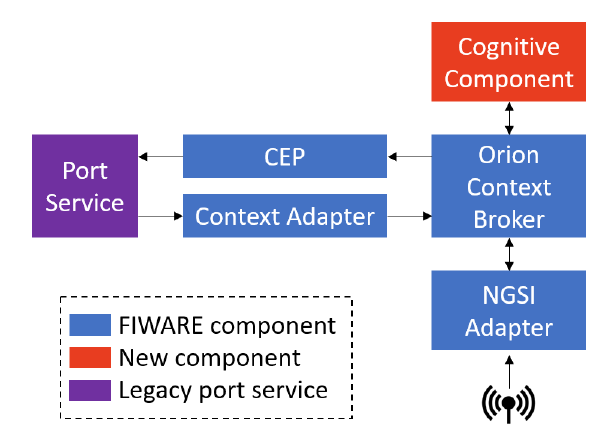
Figure 1. Simplified system